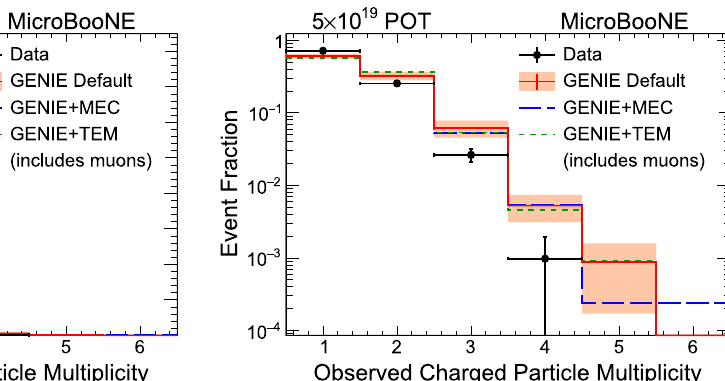
from the fit. Monte Carlo error bands include MC statistical uncer- tainties from the fit and systematic uncertainty contributions added in